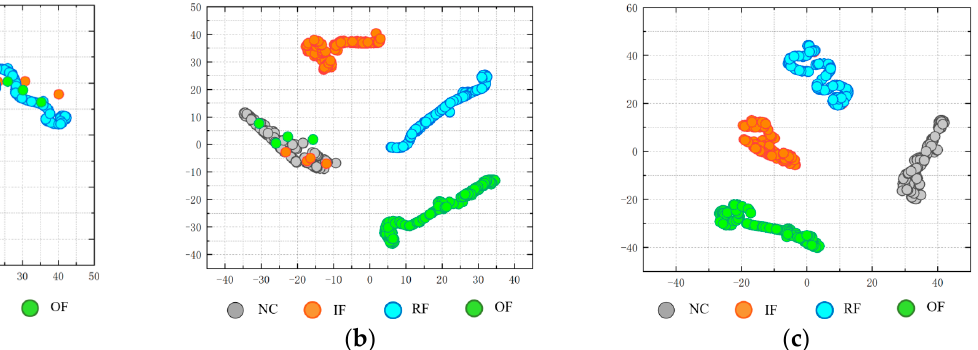
Figure 16. Dimensionality reduction visualization results on Dataset C: ( a ) GAN. ( b ) WGAN. ( c ) WGAN-GN.